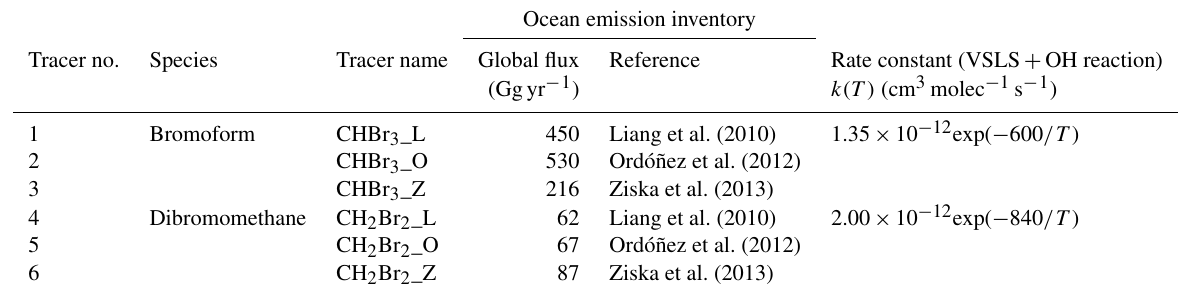
Table 1. Summary of the VSLS tracers simulated by the models, the global total emission flux (GgVSLSyr − 1 ) and the rate constant for their reaction with OH (Sander et al., 2011). See text for details of emission